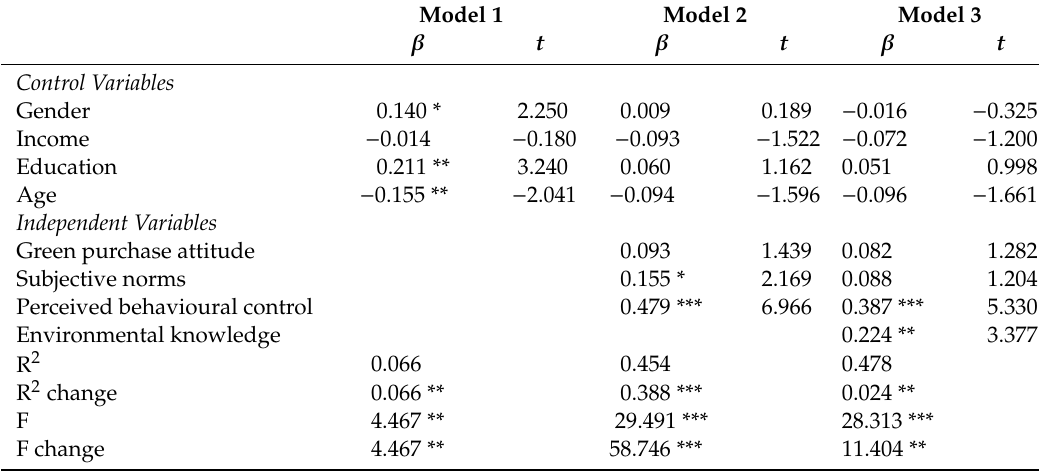
Table 5. Regression analysis.